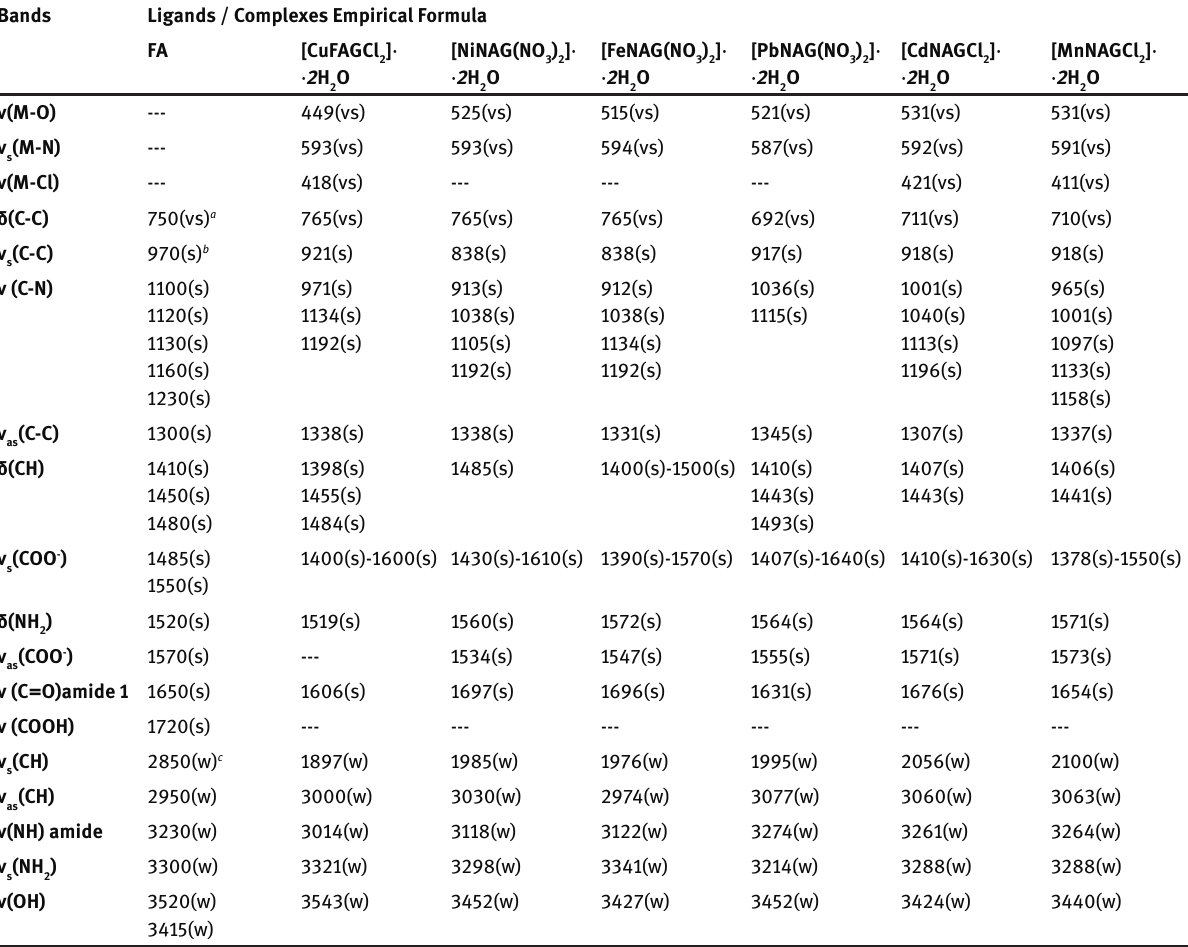
Table 3 Infra-red (IR) spectra band frequencies (cm -1 ) of mixed vitamin B9 (FA) – glycine (G) –metal drug complexes Bands Ligands / Complexes Empirical